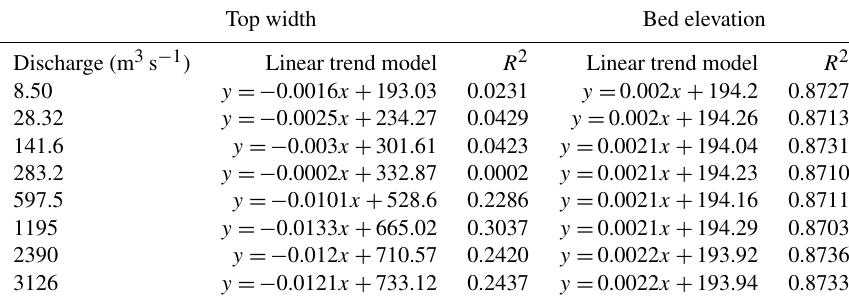
Table 2. Linear trend models and R 2 for Z and W j used in detrending each